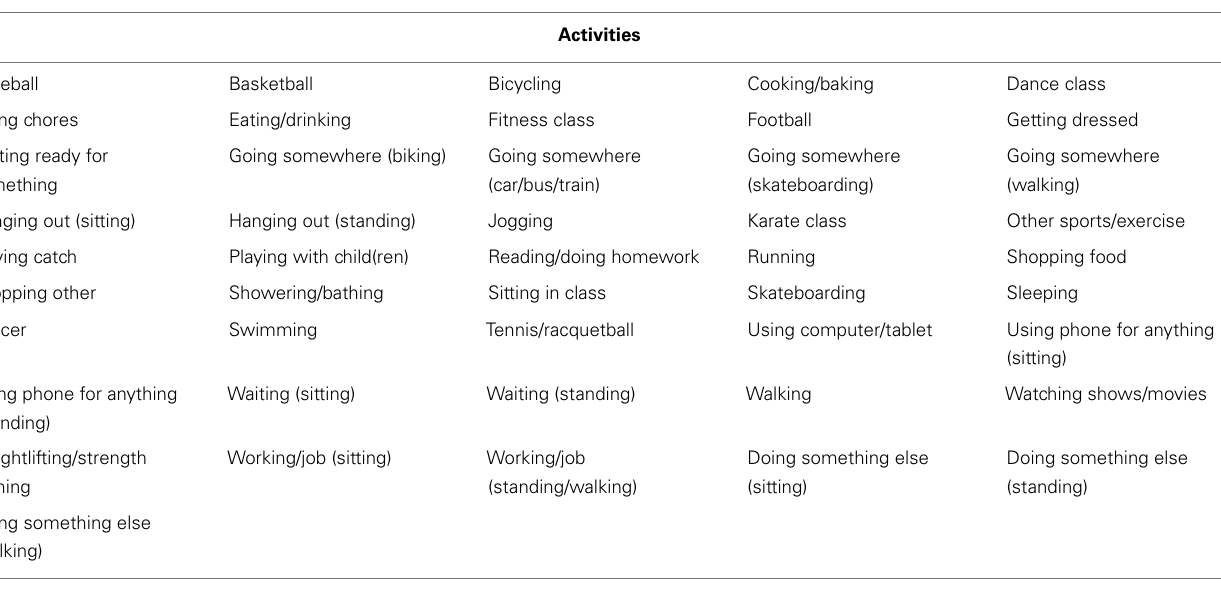
Table 3 | Sensor-assisted end-of-day recall activity list .